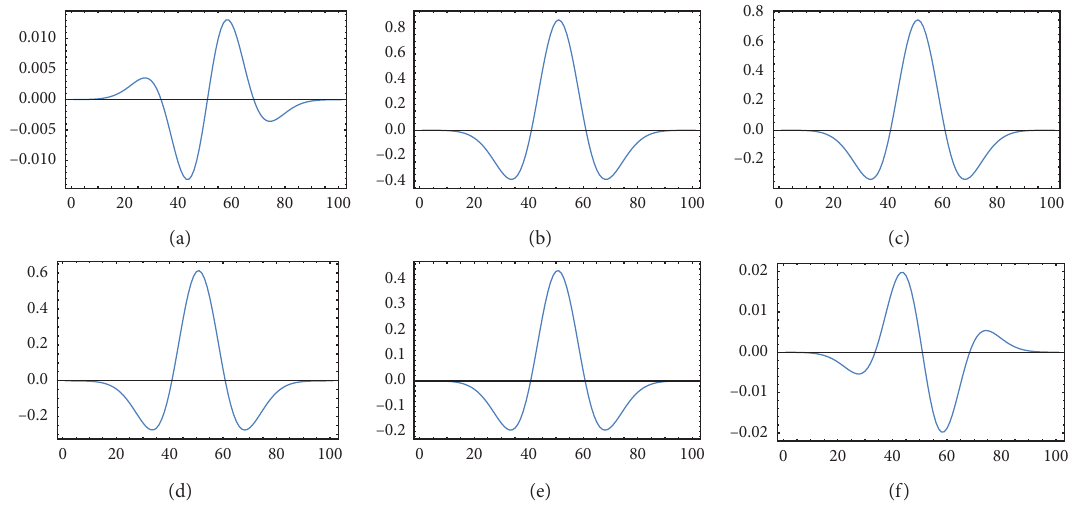
Figure 2: HT of Mexican Hat wavelet and FRBTs of Mexican Hat wavelet at θ � 0 , π /6 , π /4 , π /3 , π /2. (a) HT of Mexican Hat wavelet. (b) FRBTof Mexican Hat wavelet with θ � 0. (c) FRBTof Mexican Hat wavelet with θ � π /6. (d) FRBTof Mexican Hat wavelet with θ � π /4. (e) FRBT of Mexican Hat wavelet with θ � π /3. (f) FRBT of Mexican Hat wavelet with θ � π